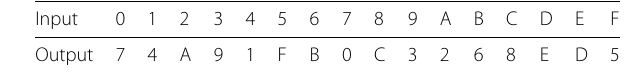
Fig. 3 Encryption processing of LBlock